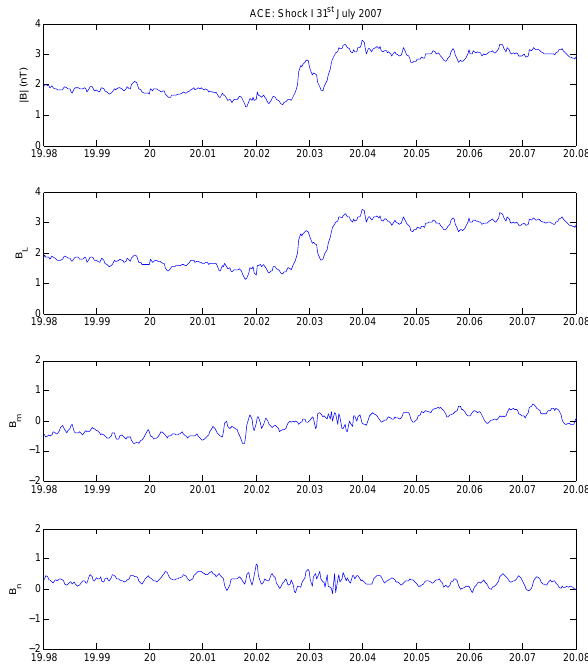
Fig. 10. Shock I: observed by ACE at 20.03UTC on 31 July 2007. See caption of Fig. 7 for | B | , B L , B m and B n .